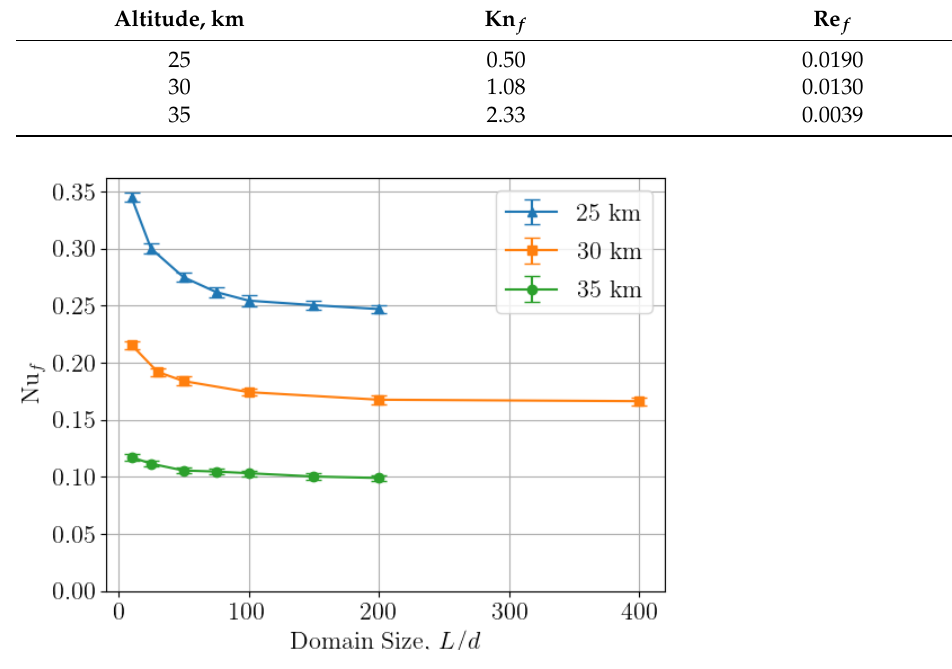
Figure 5. Dependence of hotwire heat transfer on the simulation domain size. Error bars indicate ± 1 σ of the steady-state DSMC